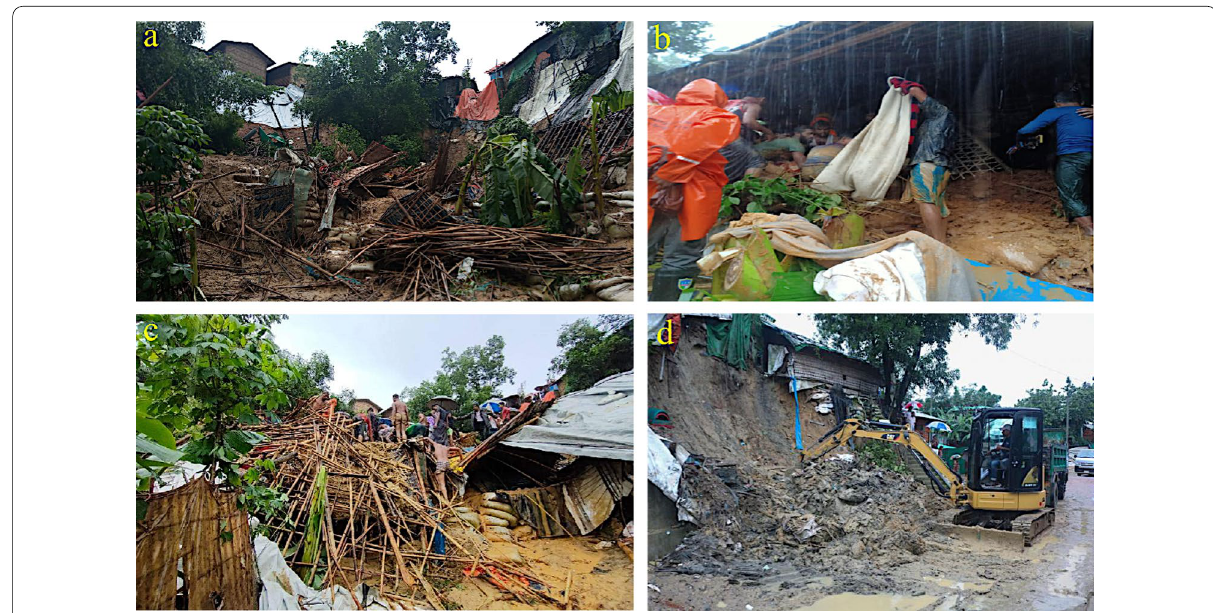
Fig. 8 a Mud and garbage deposited on the slope base, b and c emergency rescue operations by the local people and volunteers, and d cleaning of the site and road by an excavator. Source The authors, fieldwork, August